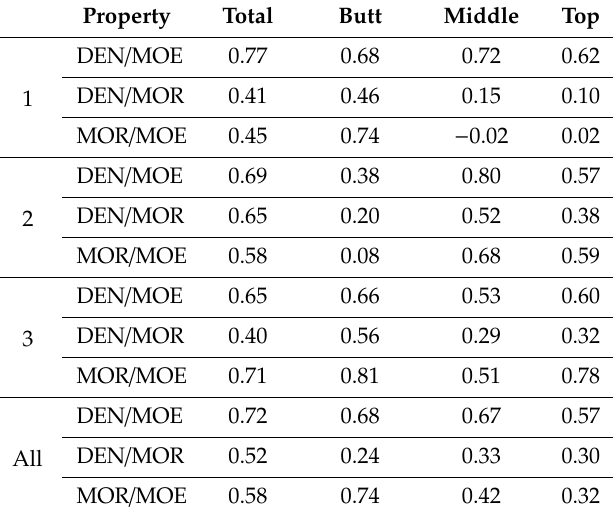
Table 3. Correlation coe ffi cient between the given physico-mechanical